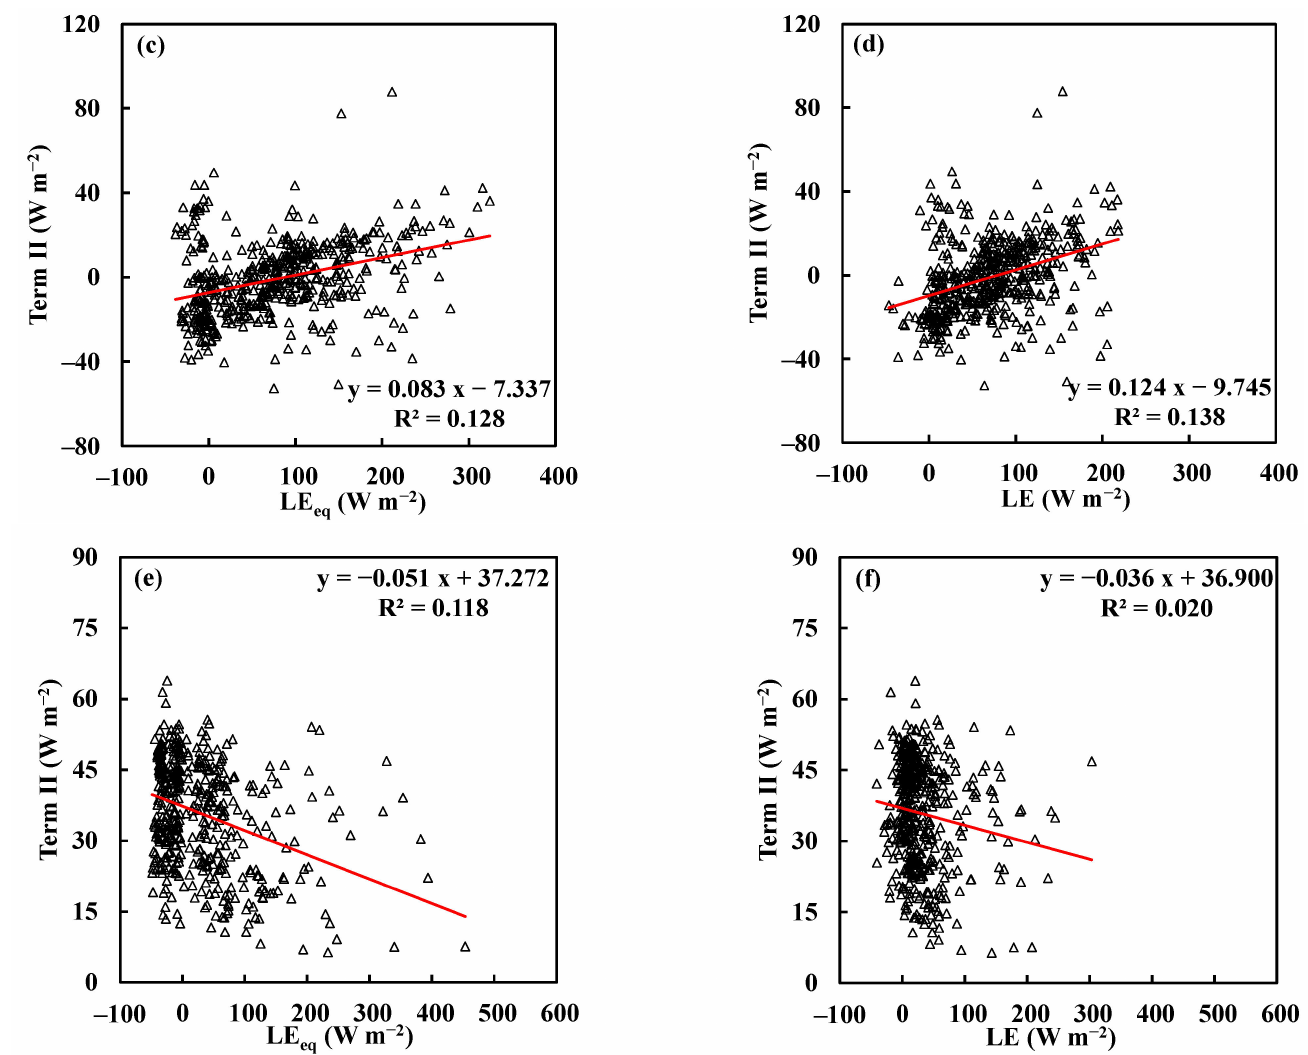
Figure 11. Scatter plots of term II as a function of LE eq and measured LE above the grassland ( a , b ), peat bog ( c , d ), and forest ( e , f ).